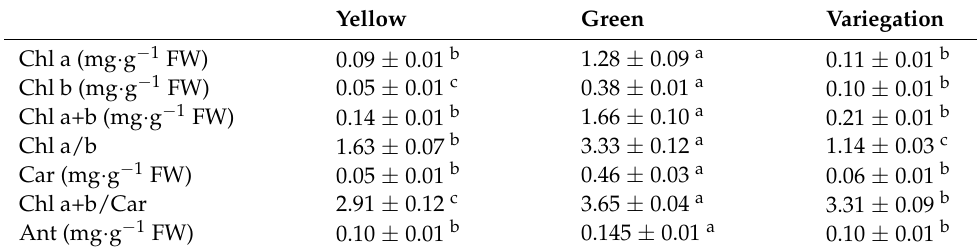
Table 1. Pigment contents in yellow leaves and green and yellow sectors of variegated leaves. Yellow Green